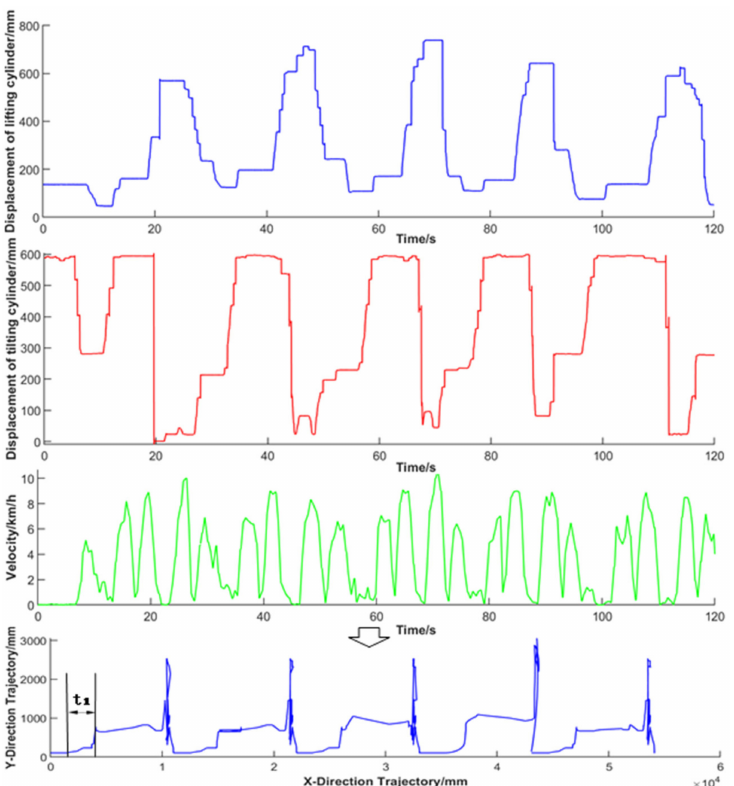
Figure 9. Indirect measurement parameter curve and synthetic trajectory